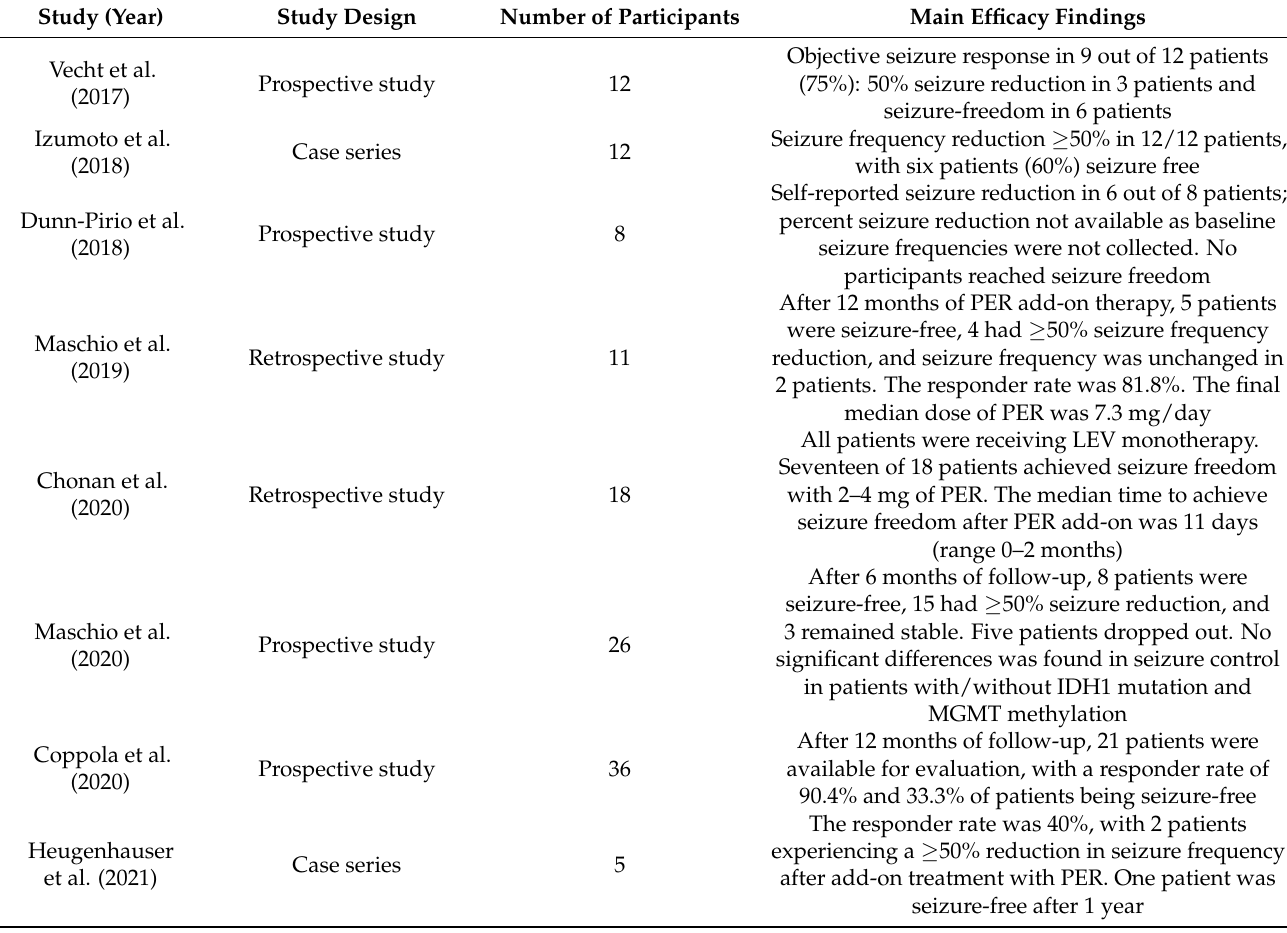
Table 2. Main characteristics of clinical studies and efficacy findings of perampanel in patients with brain tumor-related